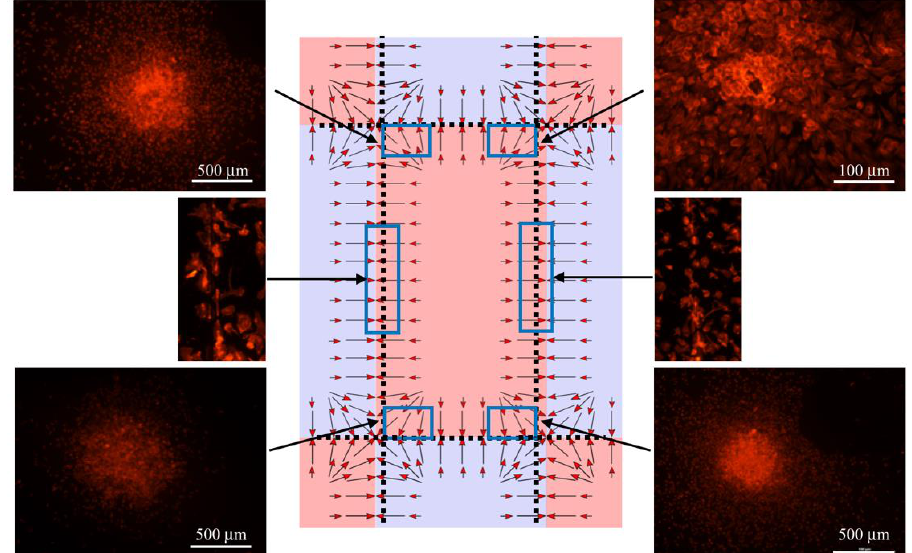
Figure 6. Pattern of the macrophages’ density in the magnetic field with contrast agent added. The macrophages were also grouped in the central magnet corners and along the edges according to the magnetic gradient field generated by the mechanical force pattern. Due to the paramagnetic properties of the contrast agent, the forces acting on the macrophages were significantly enhanced, which resulted in a much higher concentration of macrophages grouped in the corners and along the magnet edges compared to the no-contrast-agent case.